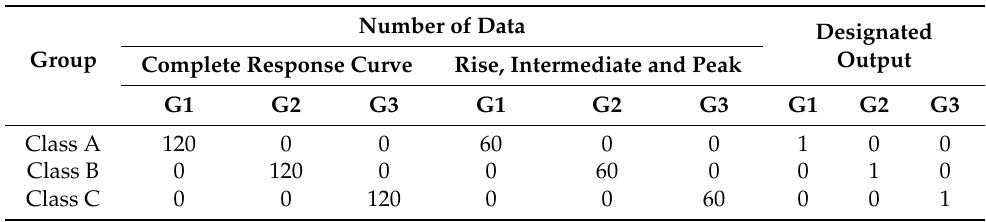
Table 6. Size of the validation dataset for each of the 13 measurement sensors, at different extracted signals.